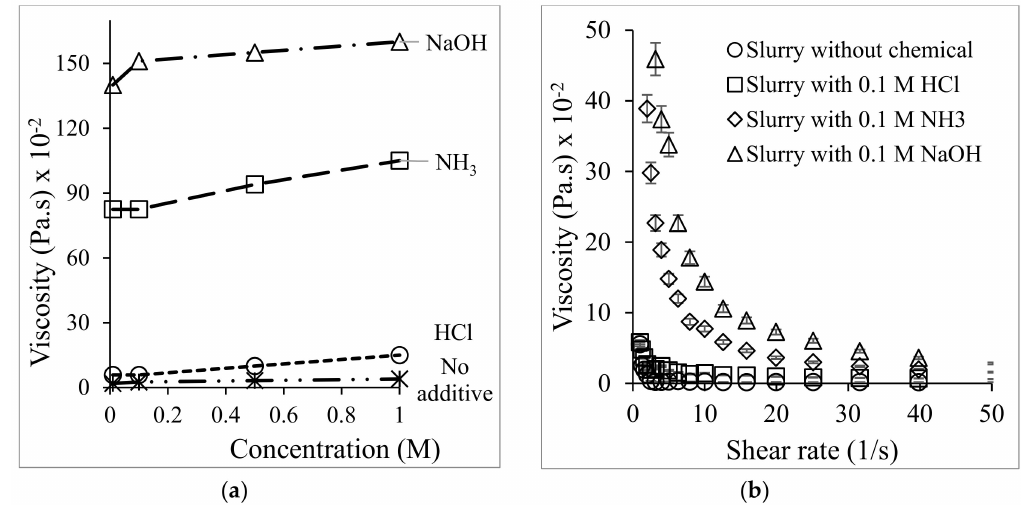
Figure 7. Viscosity changes for 60 min treatment soil slurries with additives ( a ) with di ff erent additive concentrations and ( b ) shear rate of 0.1 M additive